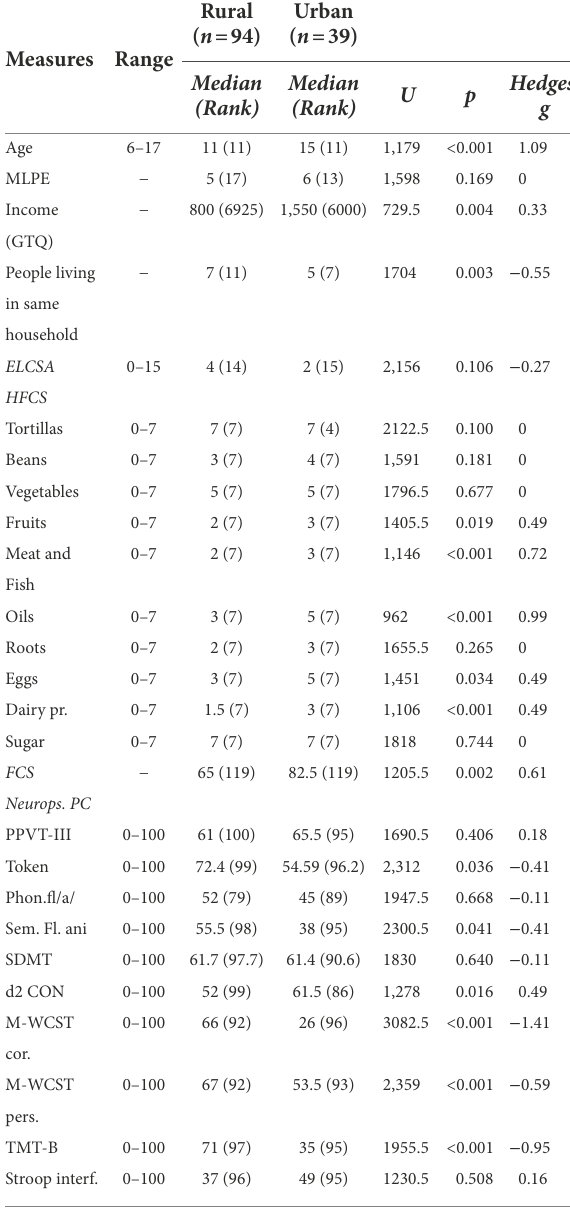
TABLE 2 Comparisons between urban and rural children in relation to food consumption and cognitive performance.